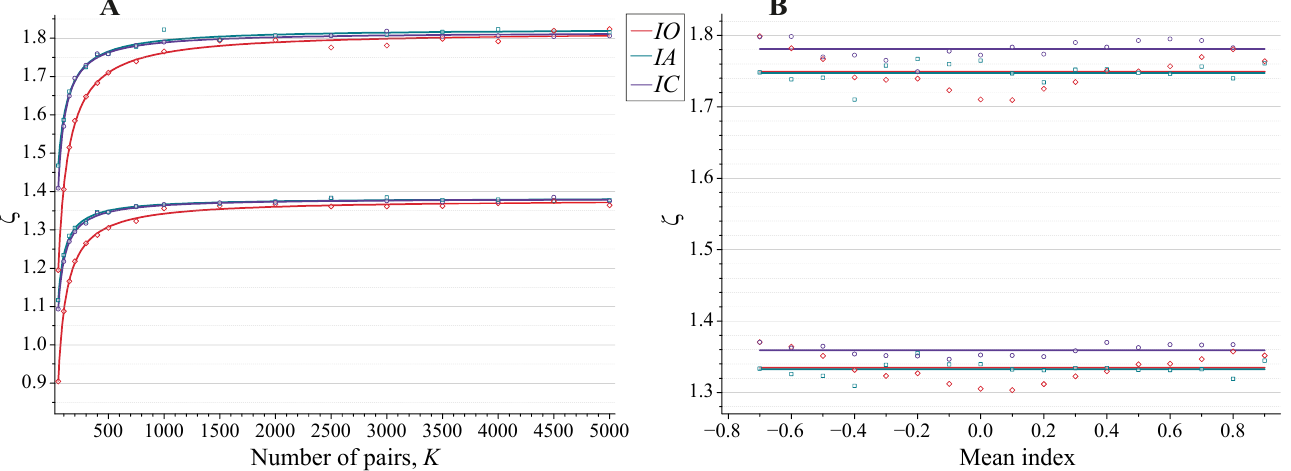
Figure 2. The absolute values of ζ parameters (Equation (15)) corresponding to empirical probabilities Pr = 0.01 (upper curves) and 0.05 (lower curves), as determined by 10 5 random realizations. Both A- and B-stretches were taken to be random. In this case, the statistics for all permuted overlapping indices (6a), (6b), and (7) were identical within statistical scattering. ( A ) The dependence of ζ parameters on the number of the nearest neighbors K . The values of all mean indices were in the vicinity of zero. The solid curves correspond to the best approximation by Equation (17). ( B ) The dependence of ζ parameters on the mean indices I (Equation (4)). The number of the nearest neighbors was 580. The dependence on the mean indices of thresholds for ζ parameters was taken as | ζ | = constant. The solid lines correspond to the related best